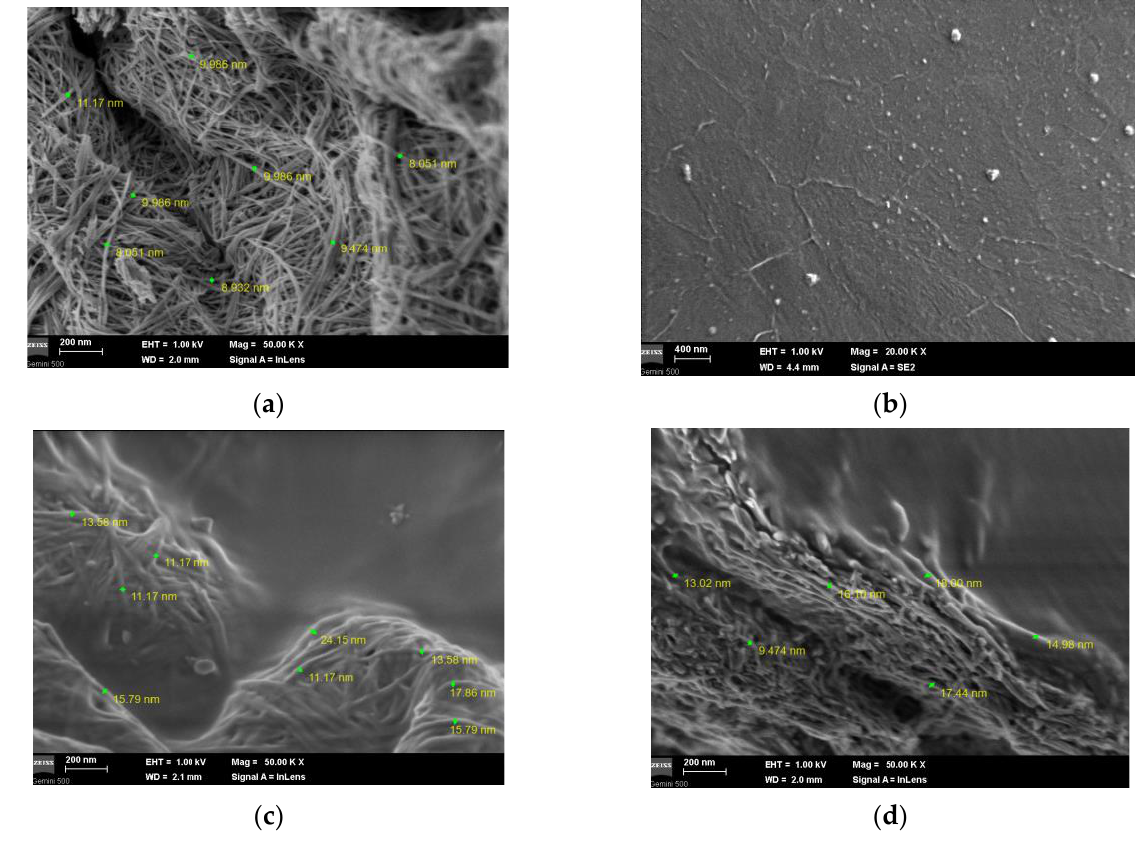
Figure 2. The SEM images of TiO 2 NWs ( a ), as well as TPU ( b ) and the TPU – TiO 2 NW composites, which have TiO 2 NW concentrations equal to 2 wt.% ( c ) and 17 wt.% ( d ), respectively.